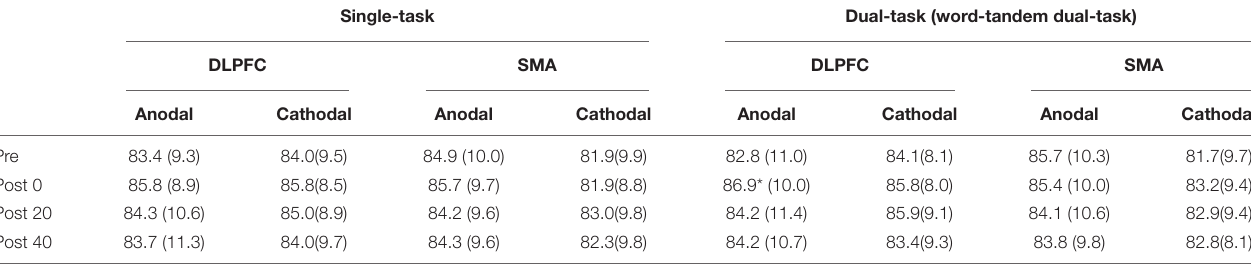
TABLE 2 | The result of the number of read out (words) in the word task under the single- and dual-task condition. Single-task